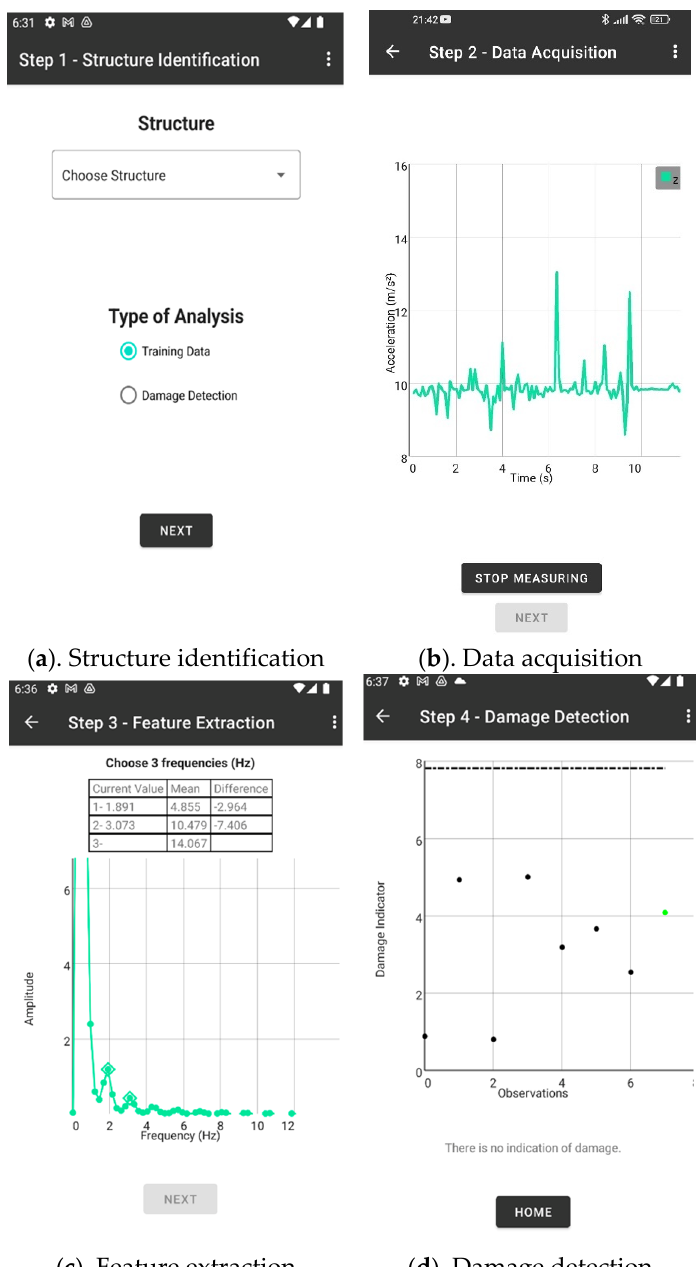
Figure 4. User interfaces of the application.